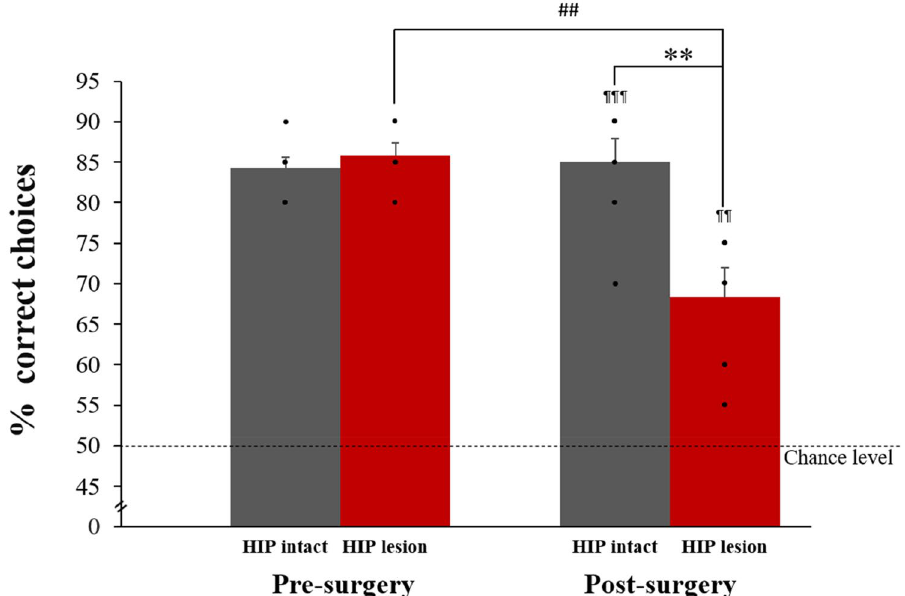
Figure 5. Pre-and post-surgery memory performance. Pre-surgery performance is comparable between HIP intact and lesioned groups. Likewise, pre and post-surgery performance did not differ for the intact HIP group. Lesion of HIP significantly altered memory performance as shown by a lower performance post- than pre- surgery in the HIP lesion group ( ## p < 0.01, at α = 0.05 Bonferroni corrected) and when compared to HIP intact performance post-surgery (**p < 0.01, at α = 0.05 Bonferroni corrected). Importantly, post-surgery, HIP lesion rats could still successfully perform the task, albeit with a lowest accuracy than HIP intact rats (comparison to chance level: ¶¶ p < 0.01, ¶¶¶ p <